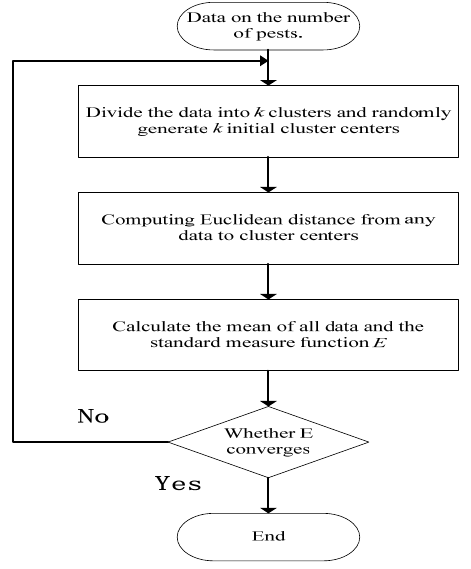
Figure 3. Flow chart of the K-Means clustering algorithm.